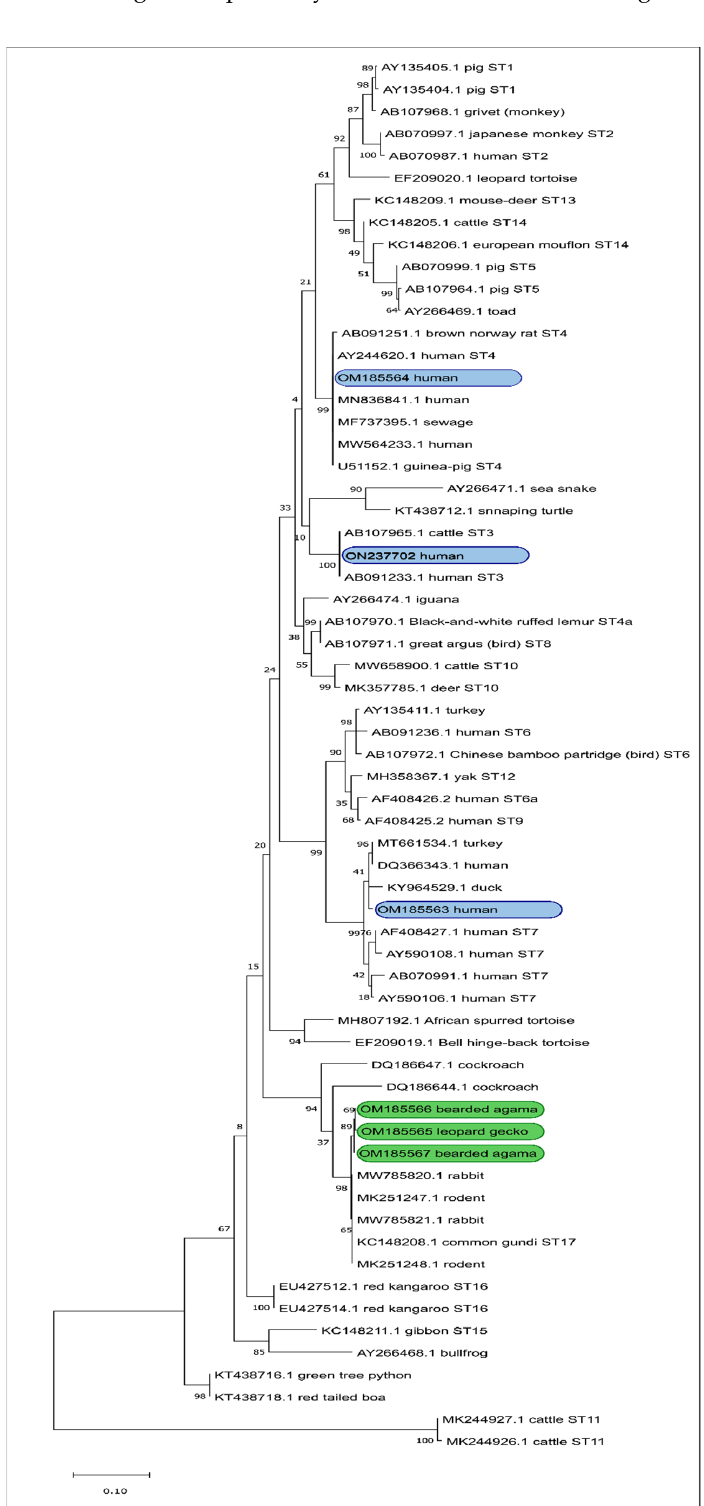
Figure 1. Molecular phylogenetic relationship of Blastocystis isolates performed using the maximum likelihood method with 1000 replications. Reptile isolates from this study are marked in green; human isolates are marked in blue.